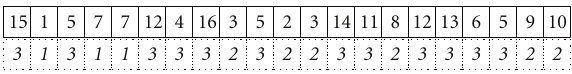
Figure 3: The feasible gene expression for a three-level shop scheduling